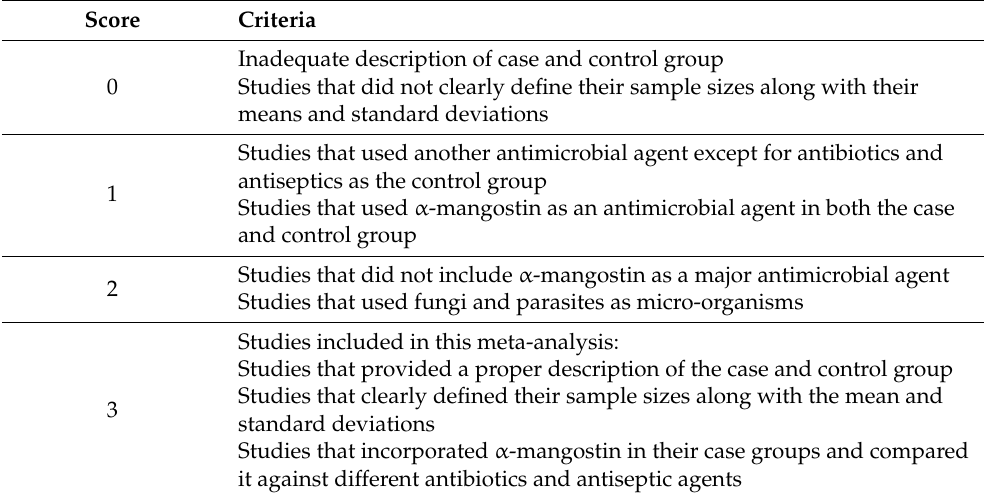
Table 2. Newcastle–Ottawa scoring criteria used for meta-analysis. Score Criteria 0